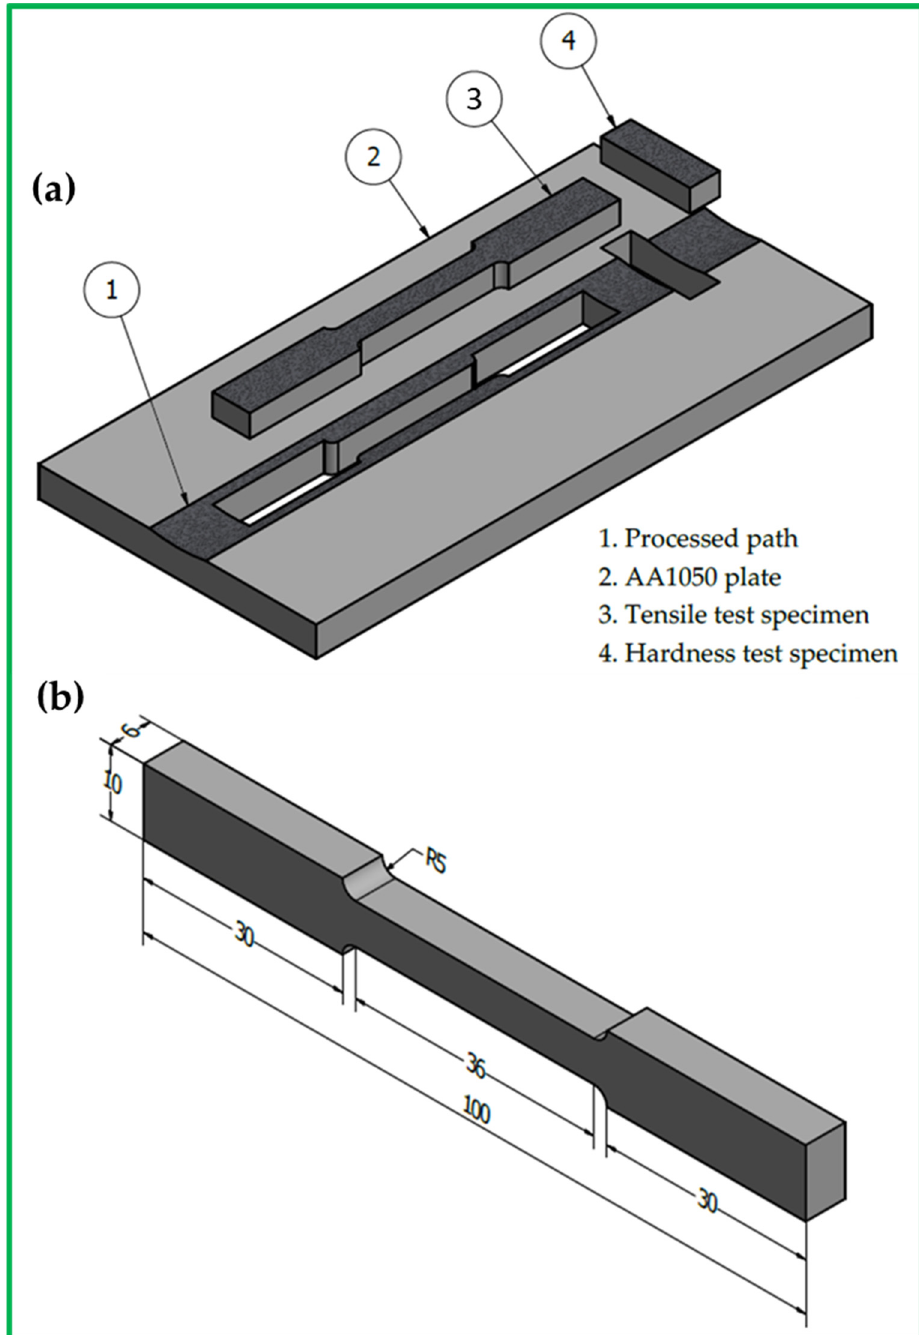
Figure 3. Three-dimensional drawings present ( a ) the location of tensile and hardness test specimens from the processed path and ( b ) the tensile specimen dimensions (all dimensions in